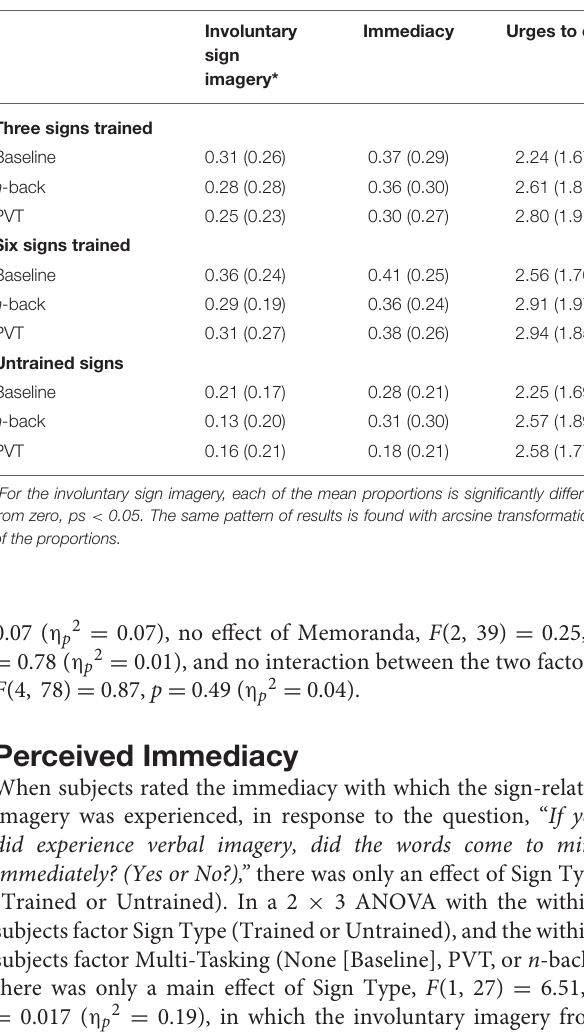
TABLE 1 | Descriptive statistics for conditions of the suppress condition, including the psychomotor vigilance task (PVT): Means per condition with SD s presented in